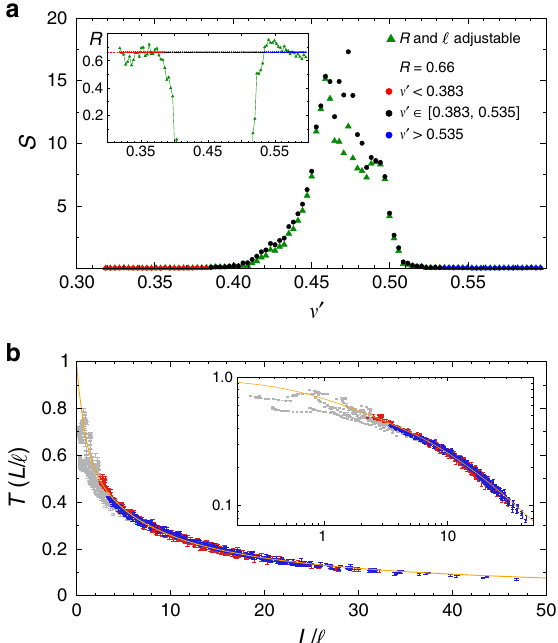
Fig. 2 Comparison to diffusion theory. a Error of the least squares of the fi t of Eq. (1), in the absence of SAL (( kl ) → ∞ ), to the data with R and ℓ as adjustable parameters (triangles). In the frequency range marked with red and blue full circles, we fi nd R = 0.66 ± 0.05 or z 0 ≃ 3.25 ± 0.5, both in the higher and lower frequency branch (inset). Full circles: results from least- Fig. 3 Position dependence of the diffusion coef fi cient in the SAL regime. squares fi tting when setting R = 0.66 constant. b Far from the gap, for (cid:5) (cid:6) D z = L ν 0 ≠ ½ 0 : 383 ; 0 : 535 (cid:2) , transport is diffusive and all data for T ( L / ℓ ) can be for kl ð Þ c ¼ 1, L / ℓ = 2 (black), L / ℓ = 20 (red) and L / ℓ = 200 (blue). a kl = 2.6; b kl = 1; and c k ℓ = collapsed on a master curve given by Eq. (1) (yellow line) with ~ L ¼ L and z = 3.25( R = 0.66). Red (blue) full circles refer to the same data at 0 shown in ( a ). Data for L < 2.7 a , not frequencies lower (higher) than ν 0 Gap taken into account for the fi tting procedure, are marked with gray symbols.